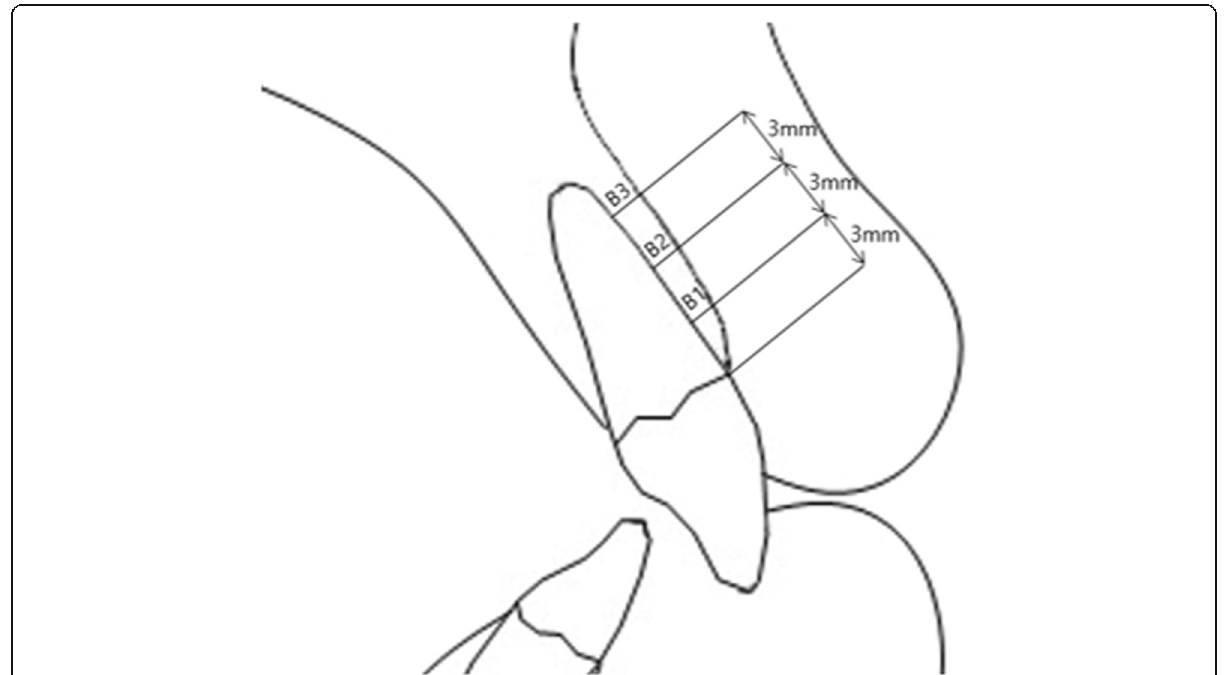
Fig. 3 Measured thickness between the incisor and surrounding bone. Distance between incisor and alveolar bone measured at 3-mm intervals from alveolar crest